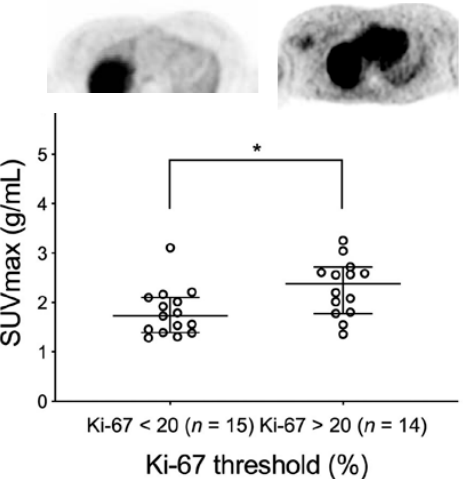
Figure 3. Uptake of [ 18 F]ISO-1 in breast cancer patients. There was a higher uptake of [ 18 F]ISO-1 in patients having a Ki-67 score >20. The image on the left is from a patient having a low Ki-67 (Ki-67 = 7.5%) score and low uptake of [18F]ISO-1, where the image on the right is from a patient having a high Ki-67 score (Ki-67 = 74%) and high uptake of [18F]ISO-1. The graph shows the significant difference in [18F]ISO-1 uptake in patients above and below the Ki-67 score of 20 (* p < 0.05). Data from reference [20].